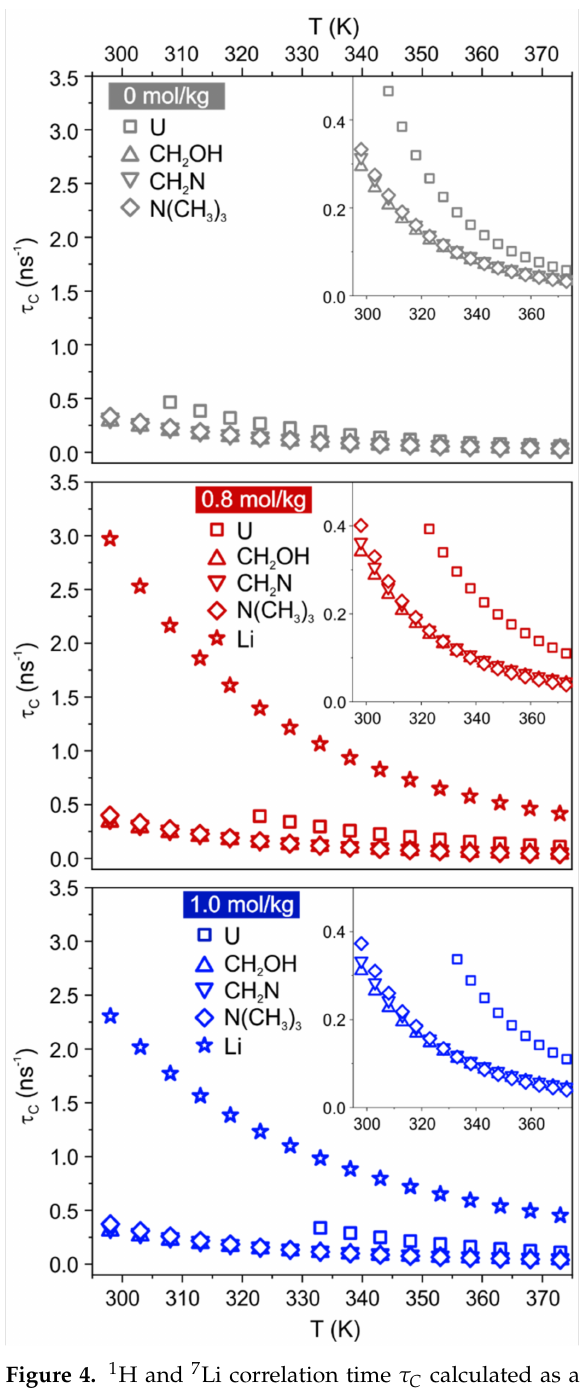
Figure 4. 1 H and 7 Li correlation time τ C calculated as a function of temperature in the samples ChCl:U-LiCl(0) (top, grey), ChCl:U-LiCl(0.8) (middle, red), and ChCl:U-LiCl(1.0) (bottom,